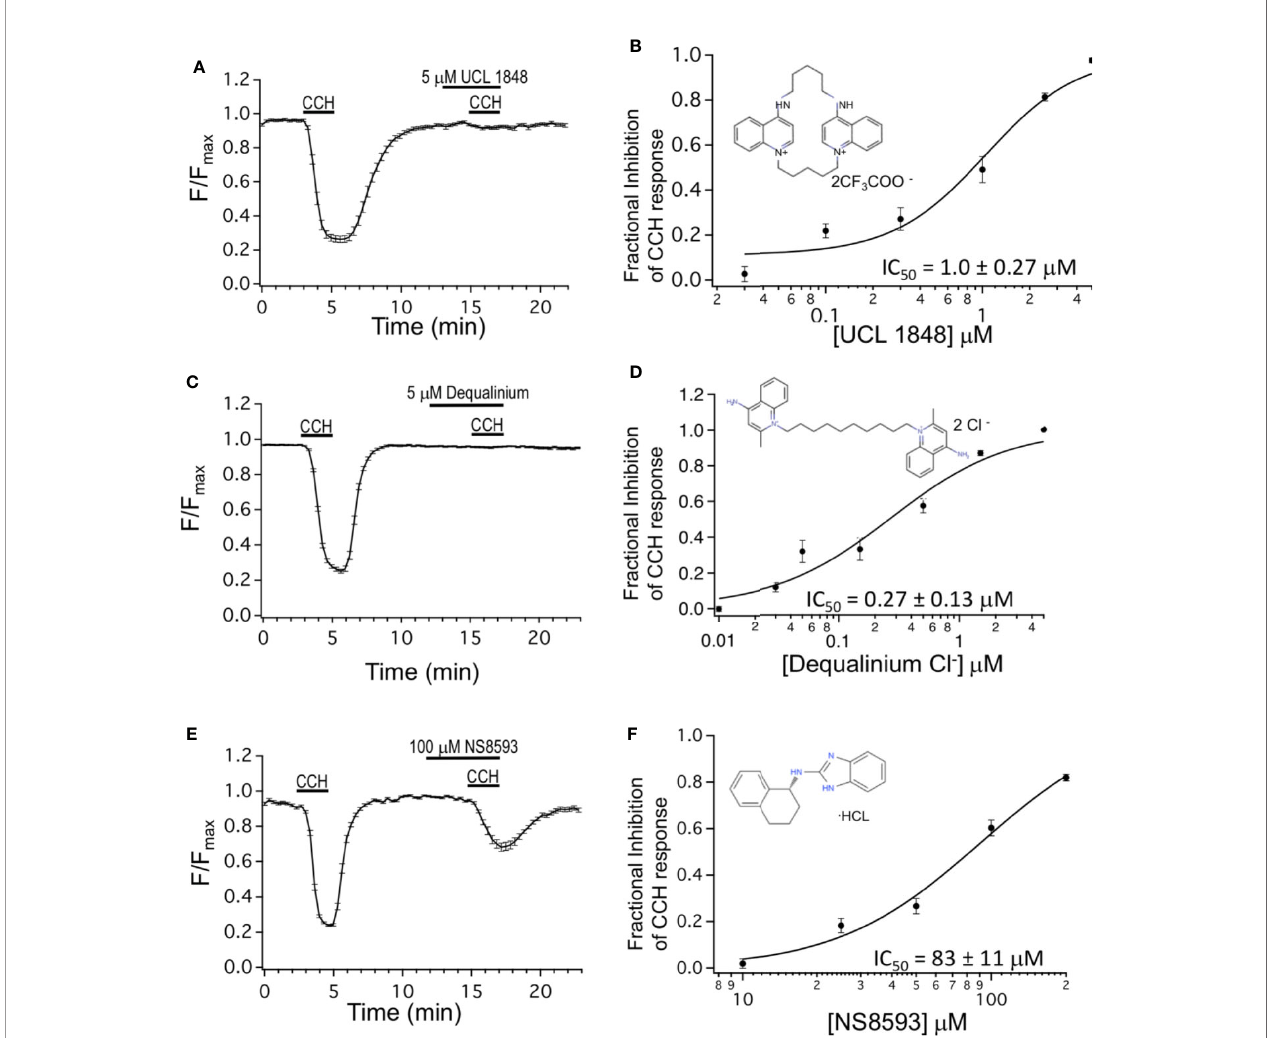
FIGURE 2 | Dequalinium compounds are M3 muscarinic receptor blockers. (A) R-CEPIAer response to repeated 0.5 m M carbachol administration with 5 m M of UCL 1848 that was applied 3 min preceding and during the second 0.5 m M carbachol administration. Fractional inhibition to UCL 1848 was 0.98 ± 0.01 for N = 32 cells. (B) Mean fractional inhibition of 0.5 m M CCH response as a function of UCL 1848 concentration (N = 20 – 32 cells per dose). Inset is the molecular structure of UCL 1848 (Chen, Galanakis et al., 2000). Fitting of data to a Hill equation revealed an IC 50 of 1.0 ± 0.27 m M, slope 1.47 ± 0.46. (C) R-CEPIAer response to repeated 0.5 m M carbachol administration with 5 m M of dequalinium chloride that was applied 3 min preceding and during the second 0.5 m M carbachol administration. Fractional inhibition to dequalinium was 0.99 ± 0.003 for N = 42 cells. (D) Mean fractional inhibition of 0.5 m M CCH in response as a function of dequalinium chloride concentration (n=15 – 42 cells per dose). Inset is the molecular structure of dequalinium chloride (Chen et al., 2000). Fitting of data to a Hill equation revealed an IC 50 of 0.27 ± 0.13 m M, slope 0.90 ± 0.29. (E) R-CEPIAer response to repeated 0.5 m M carbachol administration with 100 m M of NS8593 applied 3 min preceding and during the second 0.5 m M CCH administration. Fractional inhibition to NS8593 was 0.60 ± 0.03 for N = 30 cells. (F) Mean fractional inhibition of 0.5 m M CCH response as a function of NS8593 concentration (N=30 – 34 cells per dose). Inset is the molecular structure of NS8593 (Sorensen et al., 2008). Fitting of data to a Hill equation revealed an IC 50 of 83 ± 11 m M, slope 1.7 ± 0.35. All dose-response experiments were conducted with 0.5 m M carbachol